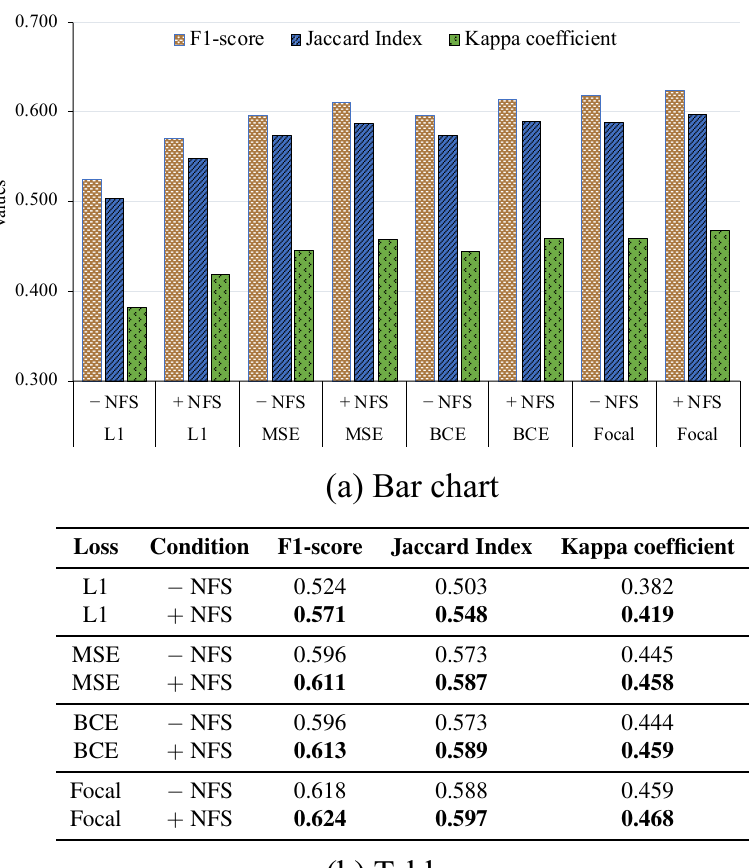
Figure 8. Performances of different losses, either with or without nearest feature selector (NFS). ( a ) Bar chart for comparison of relative performances ( b ) Table of performances under different loss functions. For each loss function, the highest values are highlighted in bold.